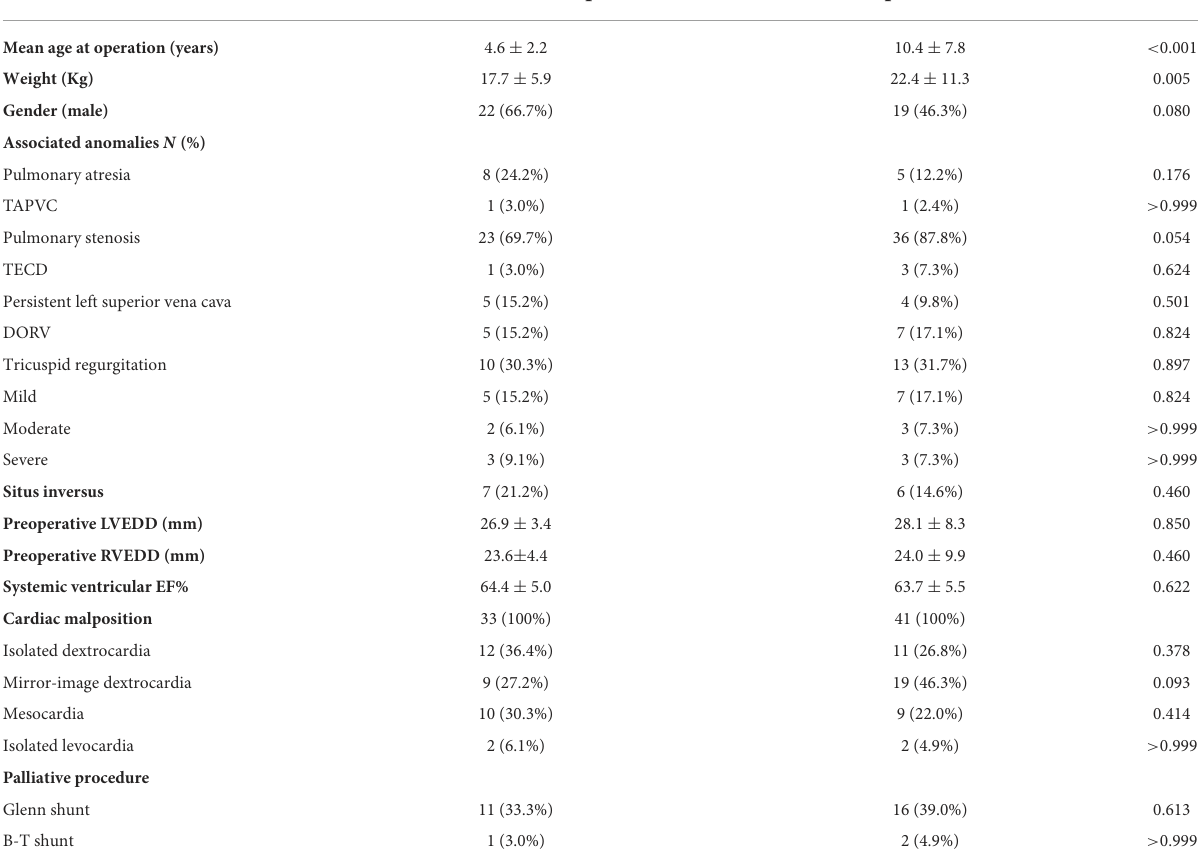
TABLE 1 Patient baseline